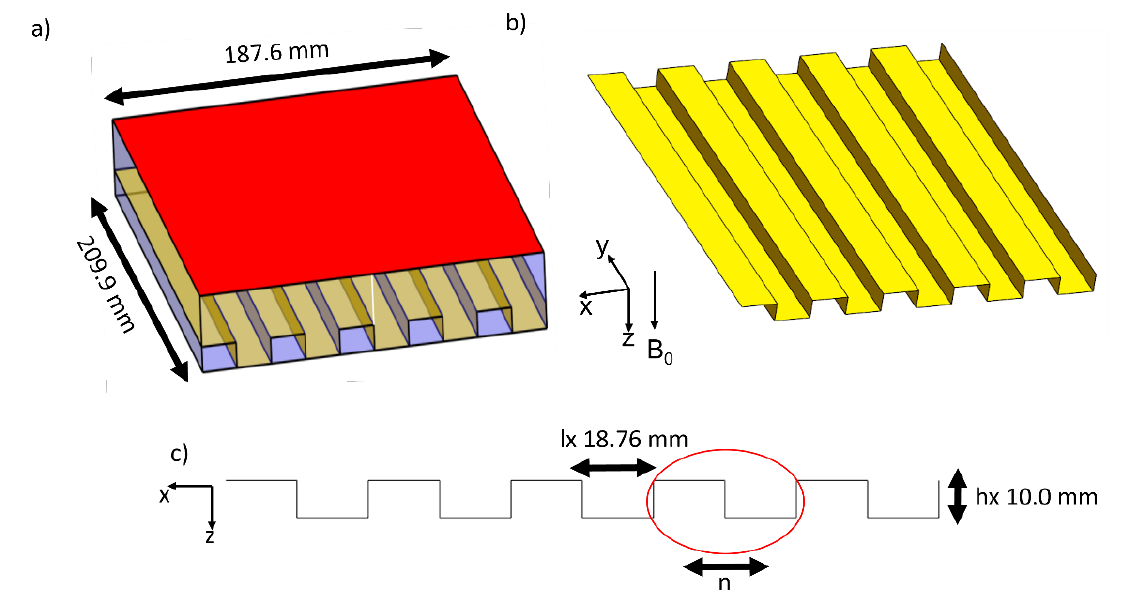
Figure 2. The design of the patch antenna ( a ) with reduction in the horizontal direction, ( b ) the ground plate showing the meandering pattern and ( c ) the diagram of the meandering pattern and dimensions.